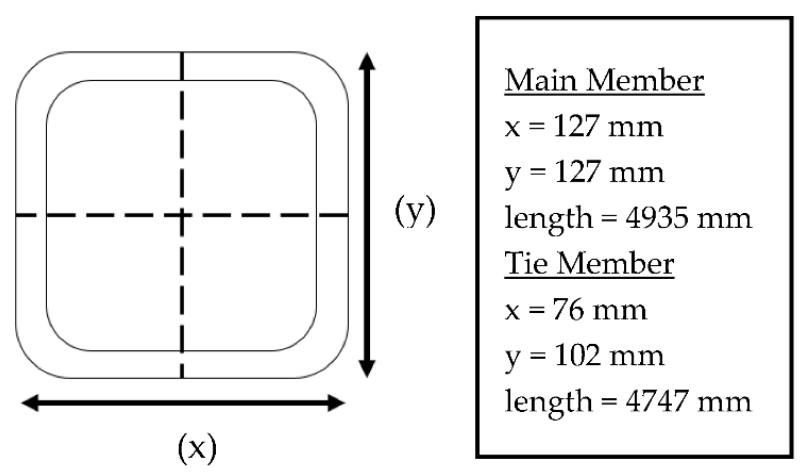
Figure 3. Schematic diagram of cross-section dimension of GFRP cross-arm for main and tie mem ‐ bers.